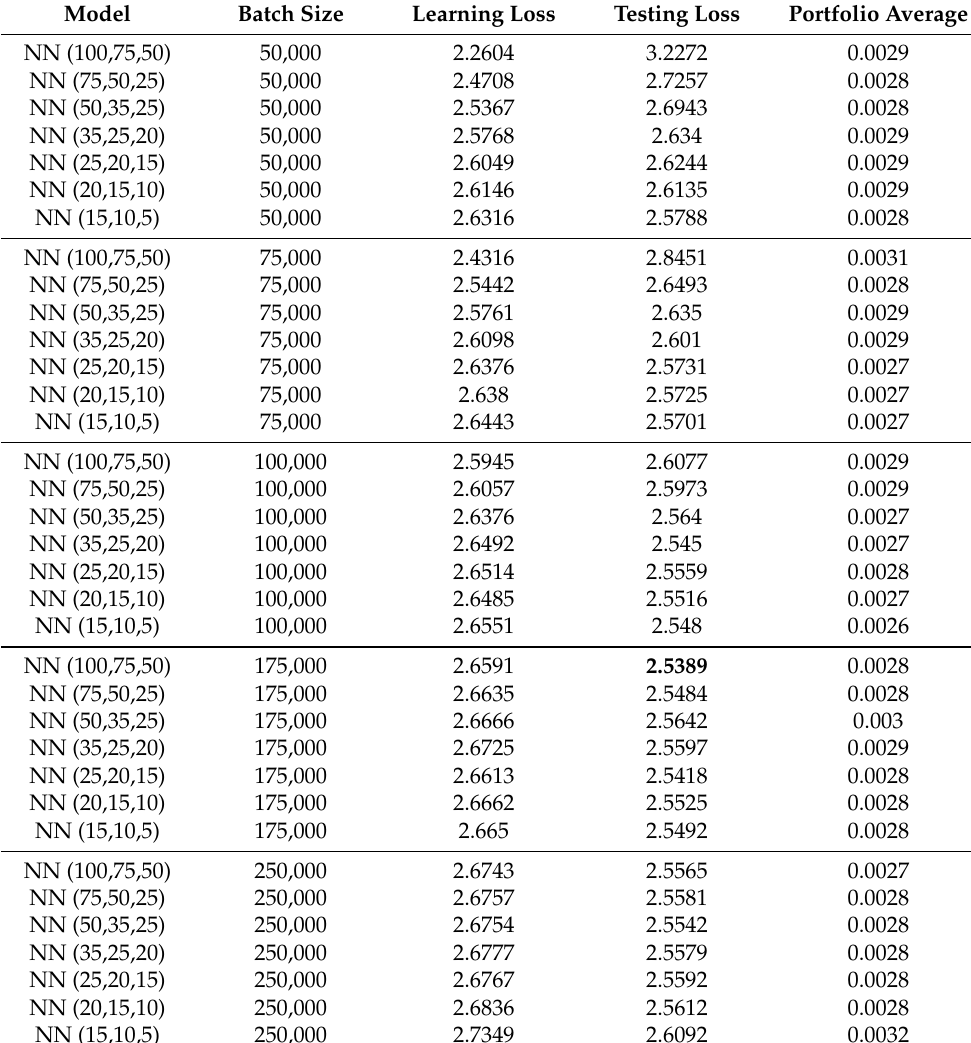
Table A5. The testing loss, learning loss, and portfolio average of the Poisson neural network